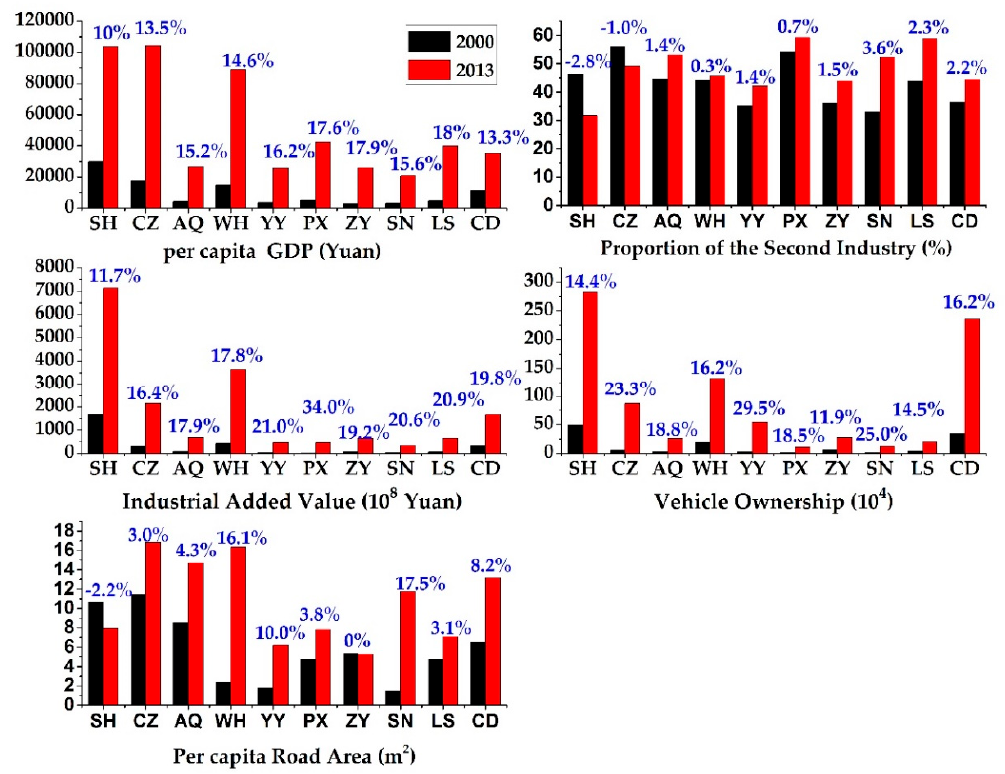
Figure 8. Changes in the socioeconomic factors and transportation metrics at the 10 prefecture- level cities of the YRB during